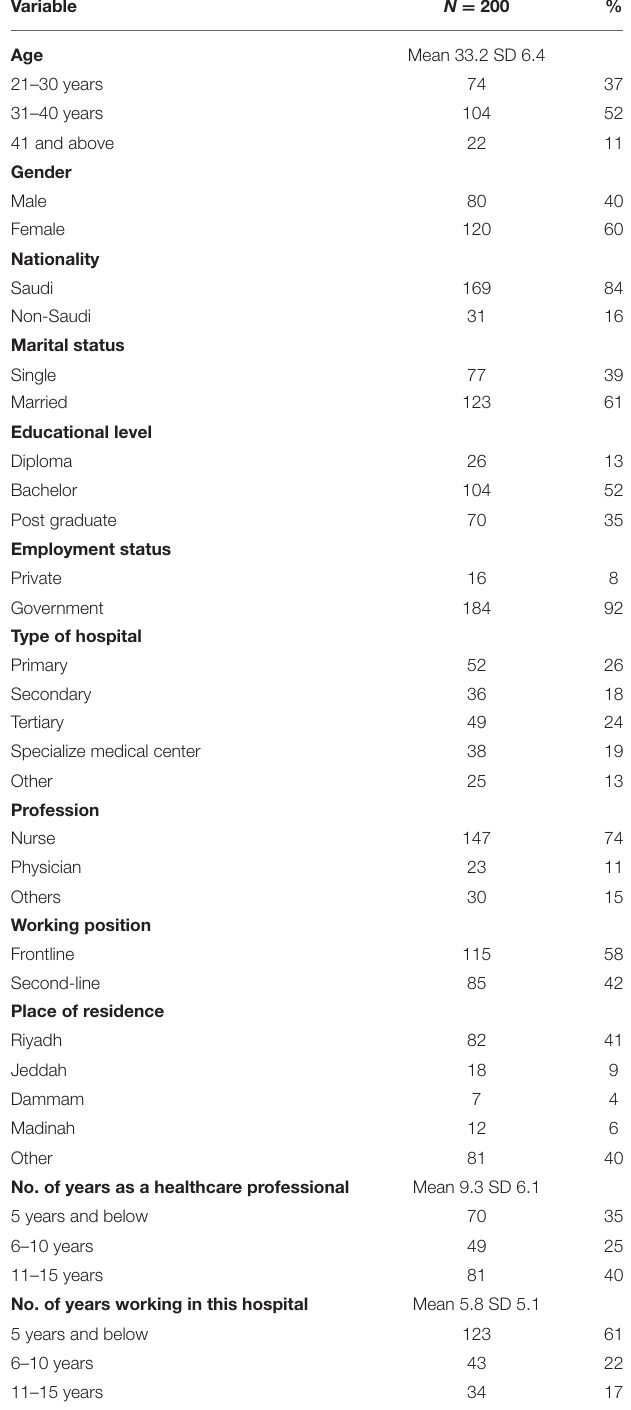
TABLE 1 | Demographic characteristic of the